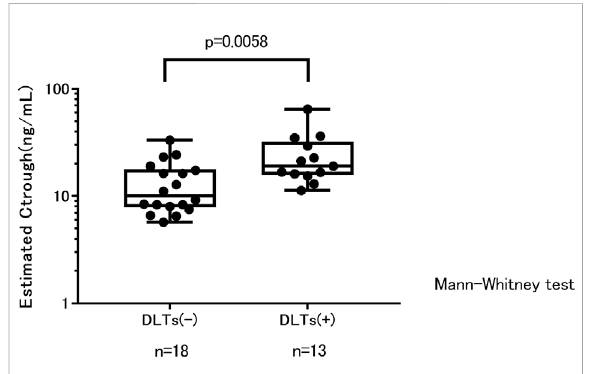
FIGURE 1 Trough concentration estimates and treatment tolerability. C trough , trough concentration; DLTs, dose-limiting toxicities.